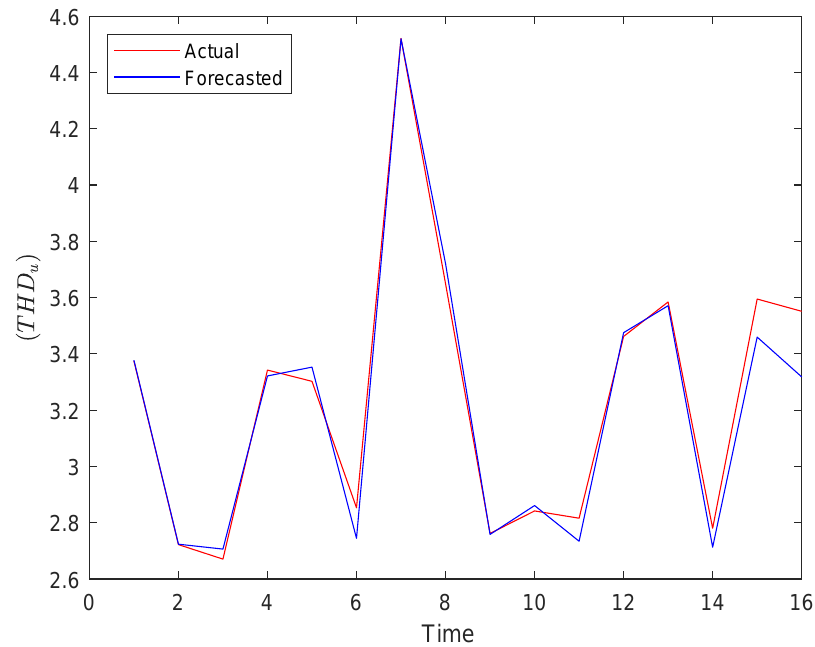
Figure 10. Comparison of actual and forecasted THD u when using DT.